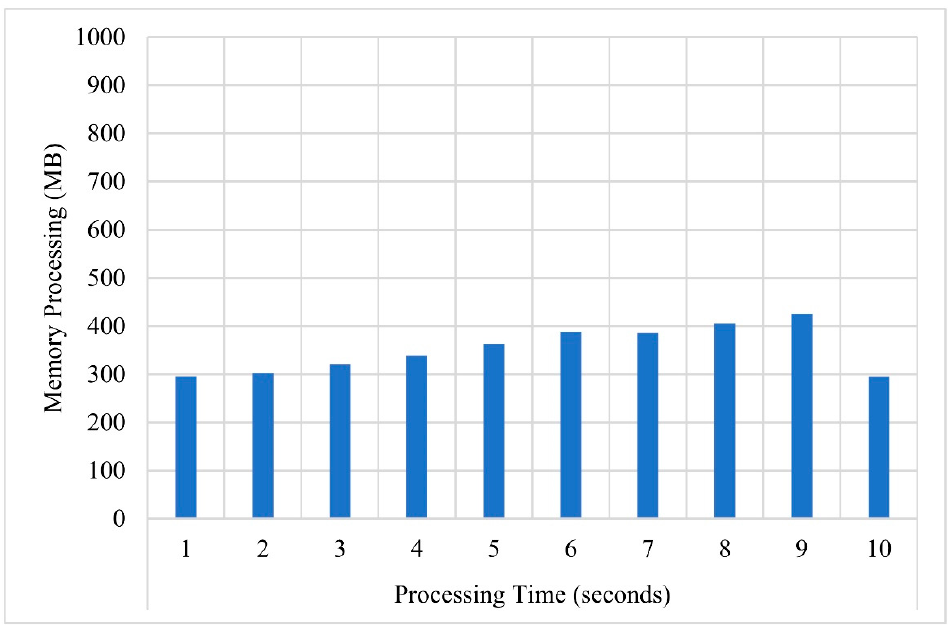
Figure 9. The consumption of device memory for the parallel mode with J48 when using CST-GR selected features.